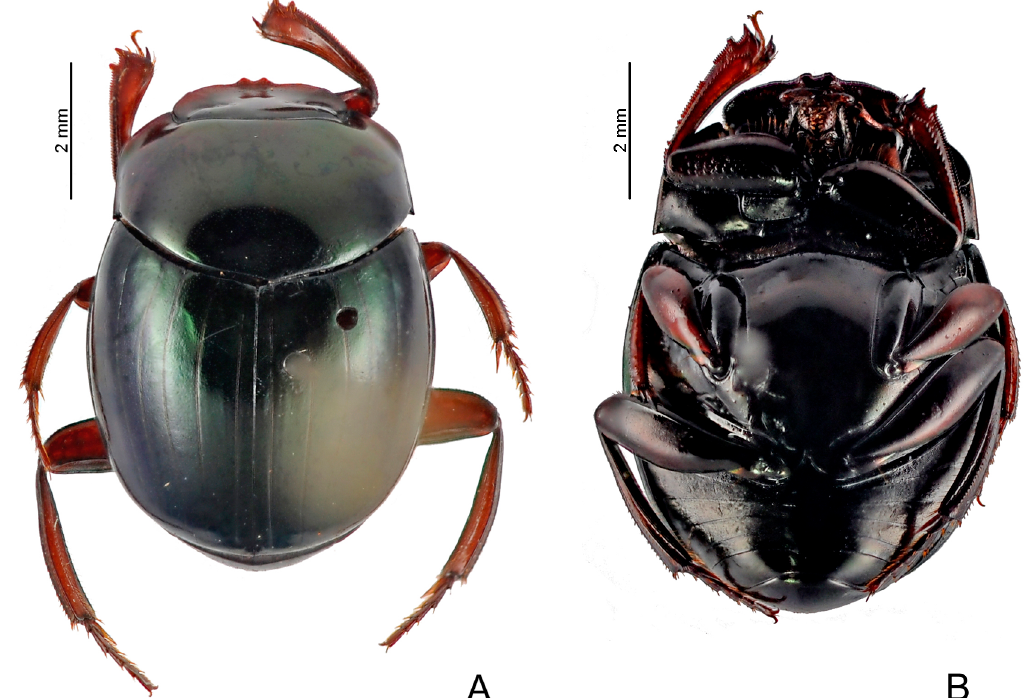
Fig. 25. Sylvicanthon candezei (Harold, 1869). A . Dorsal view. B .Ventral